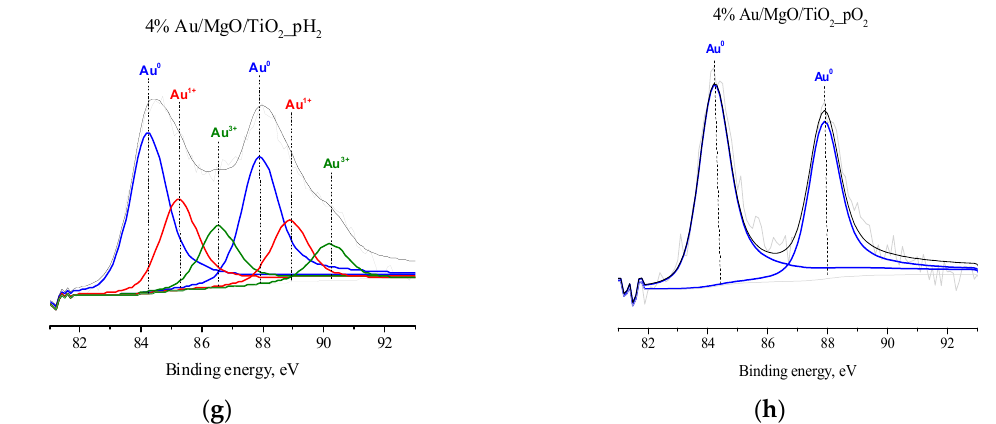
( g ) ( h ) Figure 5. Au4f XP spectra of Au/Fe 2 O 3 /TiO 2 and Au/MgO/TiO 2 samples with different gold contents Figure 5. Au4f XP spectra of Au / Fe 2 O 3 / TiO 2 and Au / MgO / TiO 2 samples with different gold contents (0.5 or 4 wt.%), pretreated in H 2 or O 2 flow, at 300 °C, for 1 h: 0.5% Au/Fe 2 O 3 /TiO 2 _pH 2 ( a ), 0.5% (0.5 or 4 wt.%), pretreated in H 2 or O 2 flow, at 300 ◦ C, for 1 h: 0.5% Au / Fe 2 O 3 / TiO 2 _pH 2 ( a ), 0.5% Au / Fe 2 O 3 / Au/Fe 2 O 3 /TiO 2 _pO 2 ( b ), 4% Au/Fe 2 O 3 /TiO 2 _pH 2 ( c ), 4% Au/Fe 2 O 3 /TiO 2 _pO 2 ( d ), TiO 2 _pO 2 ( b ), 4% Au / Fe 2 O 3 / TiO 2 _pH 2 ( c ), 4% Au / Fe 2 O 3 / TiO 2 _pO 2 ( d ), 0.5%Au / MgO / TiO 2 _pH 2 ( e ), 0.5% 0.5%Au/MgO/TiO 2 _pH 2 ( e ), 0.5% Au/MgO/TiO 2 _pO 2 ( f ), 4% Au/MgO/TiO 2 _pH 2 ( g ), 4% Au / MgO / TiO 2 _pO 2 ( f ), 4% Au / MgO / TiO 2 _pH 2 ( g ), 4% Au / MgO / TiO 2 _pO 2 ( h Au/MgO/TiO 2 _pO 2 ( h ).